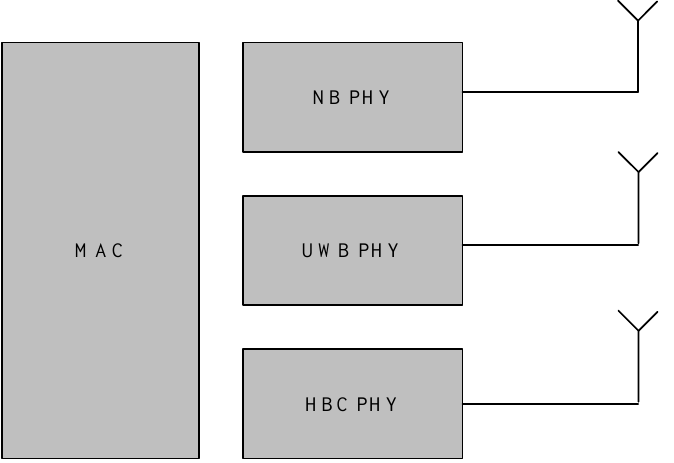
Figure 1. IEEE 802.15.6 PHY and MAC layers.